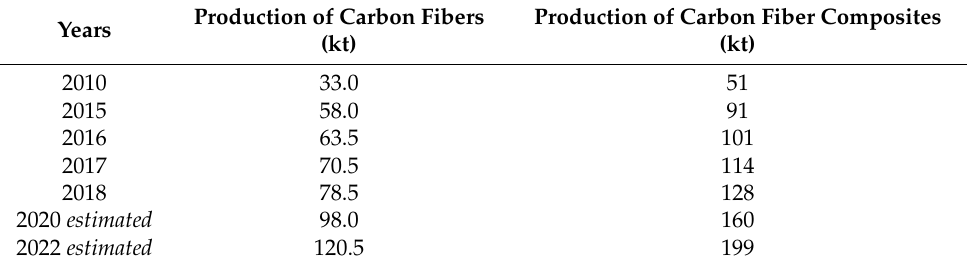
Table 3. World production of carbon fibers and composites